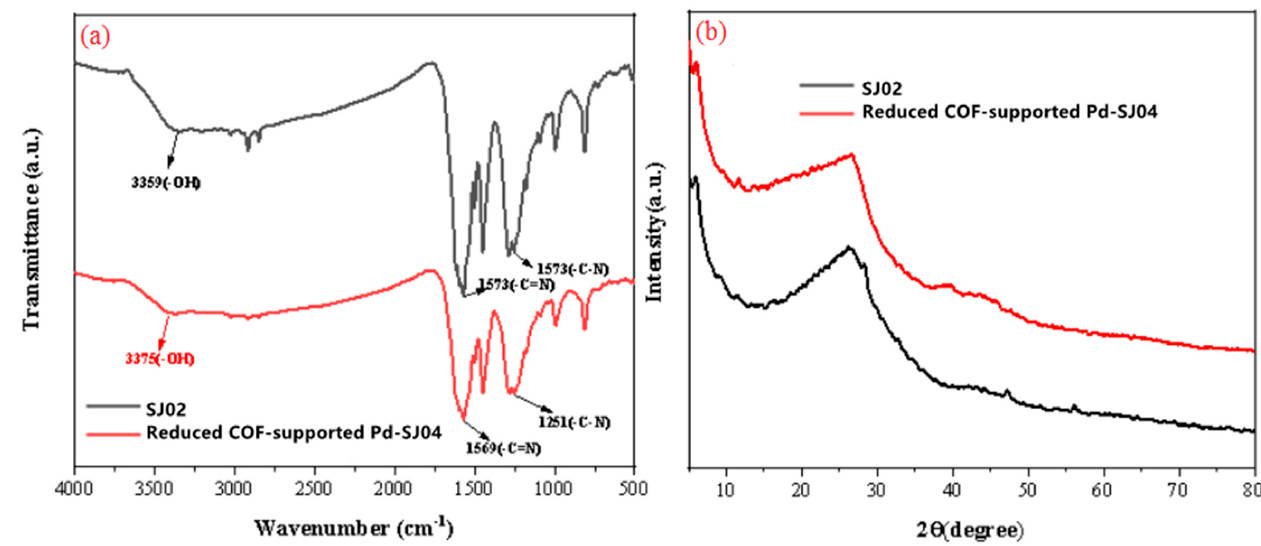
Figure 1. FTIR spectra ( a ) and XRD patterns ( b ) of SJ02 and reduced COF-supported Pd-SJ04.